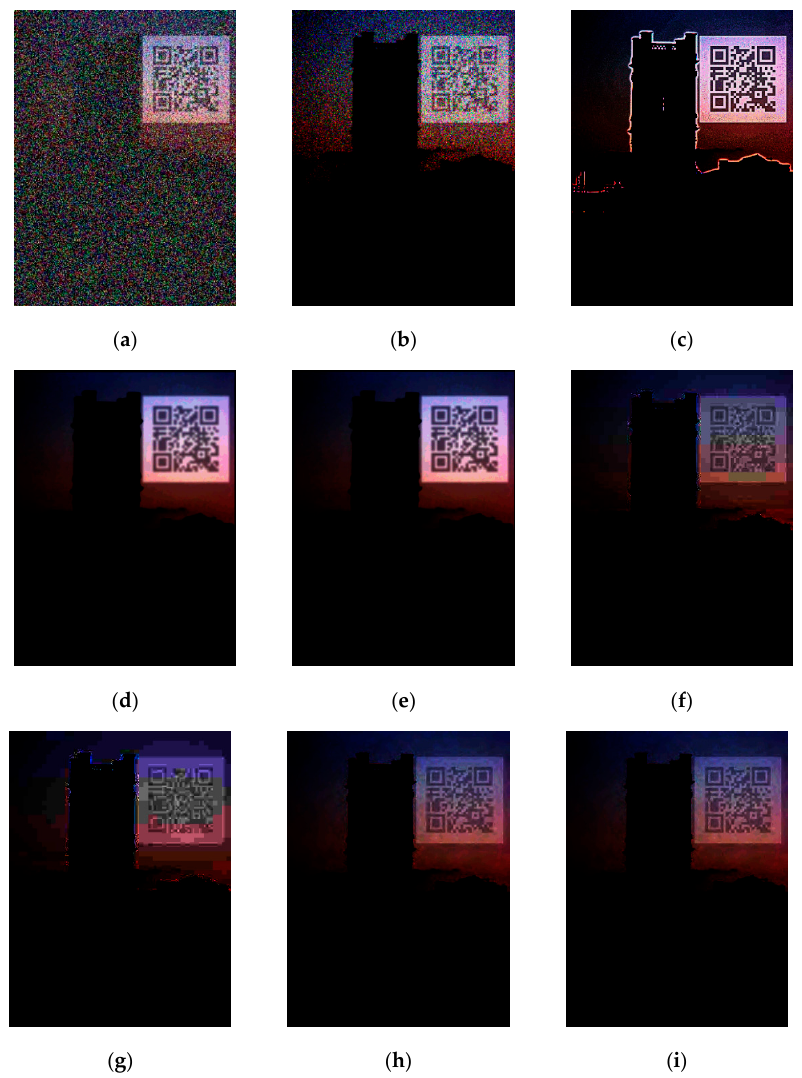
Figure 17. Robustness against image processing attacks, ( a ) impulsive noise, ( b ) Gaussian noise, ( c ) sharpening, ( d ) blurring, ( e ) average filter, ( f ) JPEG compression QF = 75, ( g ) JPEG compression QF